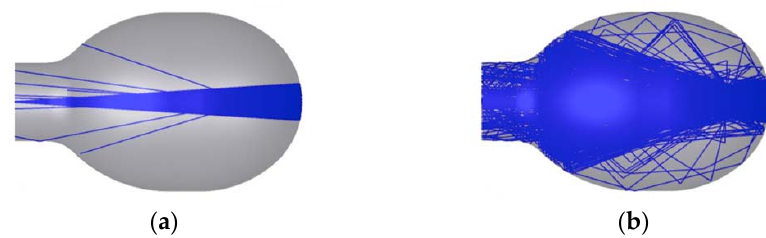
Figure 2. Zemax modeling of 200 optical rays inside the stadium resonator ( a ) without, and ( b ) with a mirror coating.